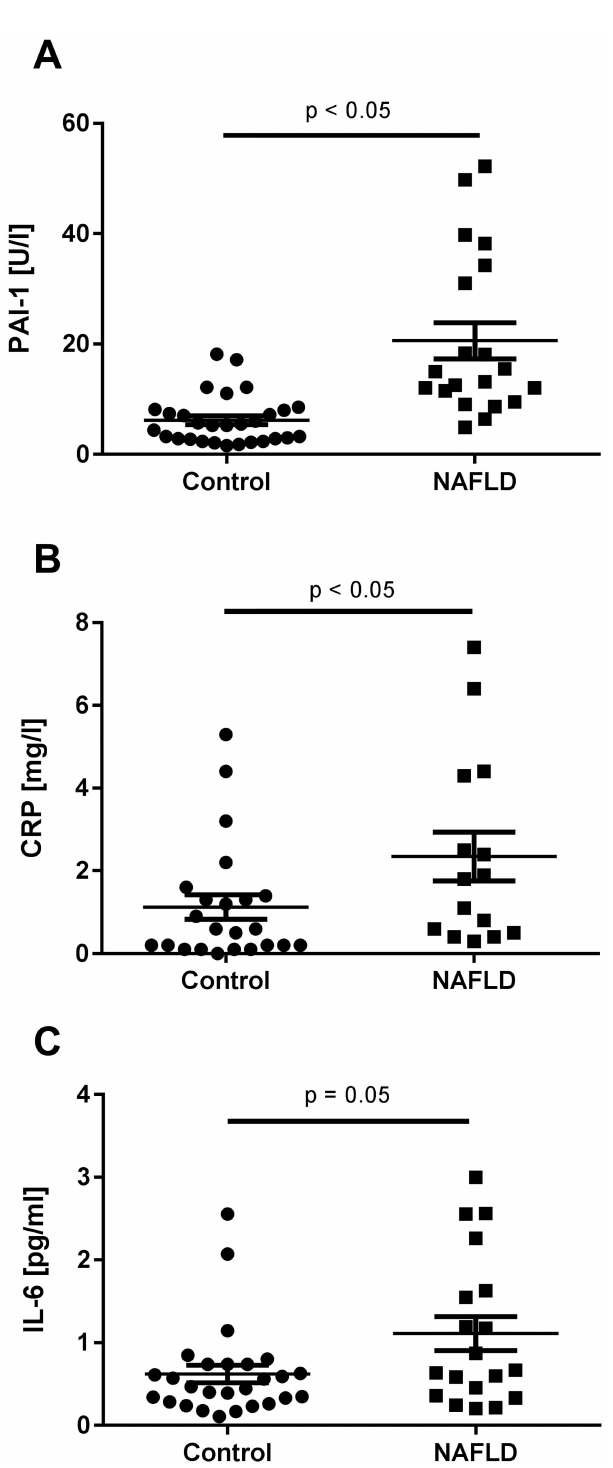
Fig 2. (A) PAI-1 plasma, (B) CRP serum and (C) IL-6 serum concentrations of controls and children with early signs of NAFLD. Data are shown as mean ± SEM, p < 0.05 is considered to be significant comparedto healthycontrol children.For the measurement of IL-6, n = 1 serum sample was insufficient. PAI- 1: plasminogen activator inhibitor-1, CRP: c-reactive protein, IL-6: interleukin-6, NAFLD: non-alcoholic fatty liver disease.